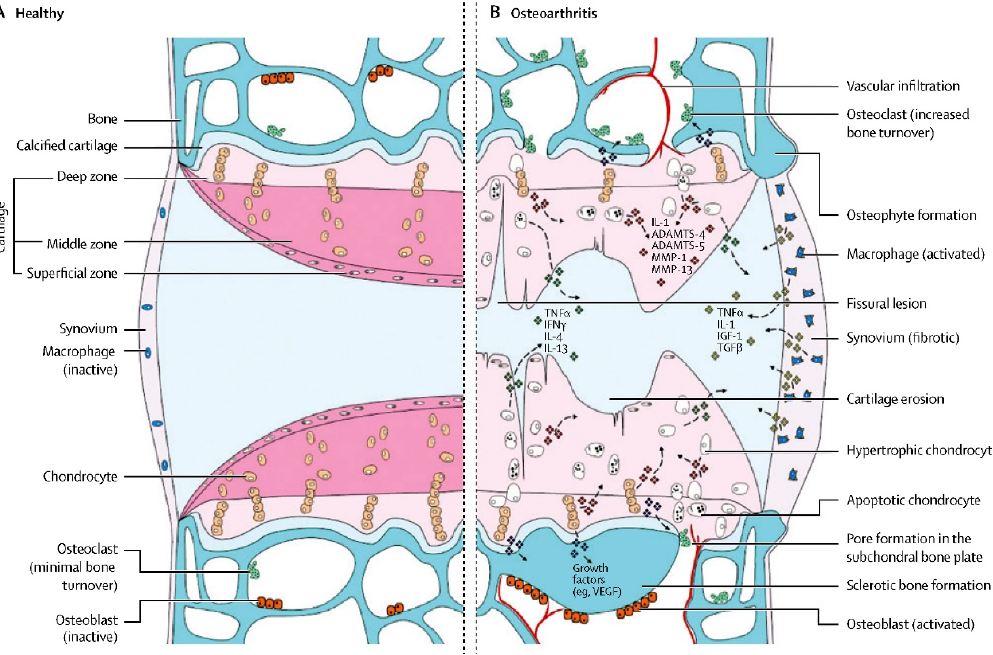
Figure 1. Comparison between normal joints and osteoarthritis. The roles of mechanical, metabolic, and inflammatory factors are identified. Reprinted from [2].